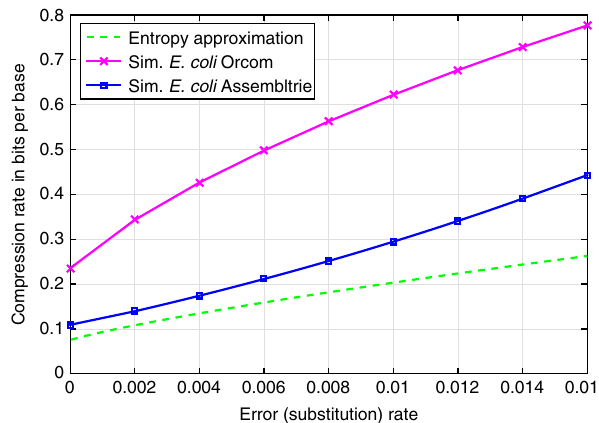
Fig. 2 Compression performance of Assembltrie as a function of error rate. The compression ratio achieved by Assembltrie is close to our information theoretic approximation on simulated reads from E.coli K-12 DH10B genome (the data set involves 1.8 M “ reads, ” i.e., substrings of length L = 101, sampled uniformly with simulated